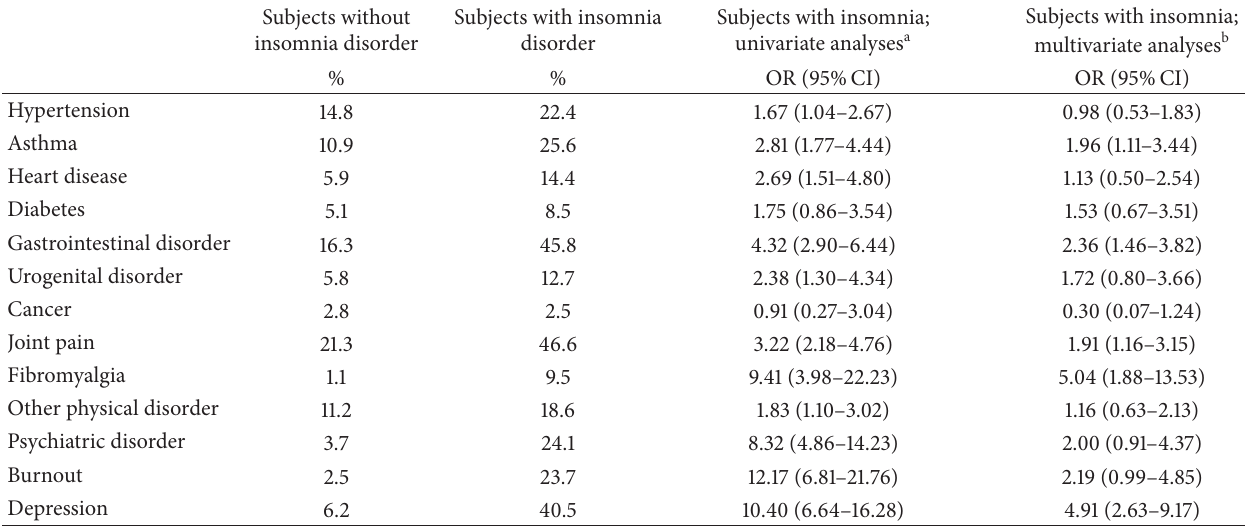
Table 4: Prevalence (%) and odds ratios (95% confidence interval) of physical and psychiatric disorders in subjects without insomnia disorder ( 𝑛 = 1005 ) and in subjects with insomnia disorder ( 𝑛 = 118